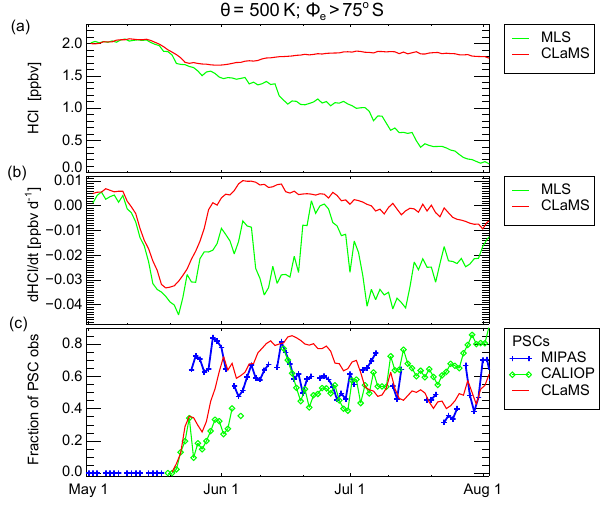
Figure 9. Vortex-core averages ( (cid:56) e > 75 ◦ S, θ = 500K) of HCl, its time derivative and PSC occurrence frequency. Panel (a) shows HCl mixing ratios from CLaMS and MLS. Panel (b) shows the cor- responding time derivative dHCl / d t (smoothed as a 6-day running mean). Panel (c) shows the fraction of MIPAS and CALIOP obser- vations with (cid:56) e > 75 ◦ S on the 500K potential temperature level that are classified as PSCs. It also shows the corresponding CLaMS results. The symbols are connected with coloured lines except for days without PSC